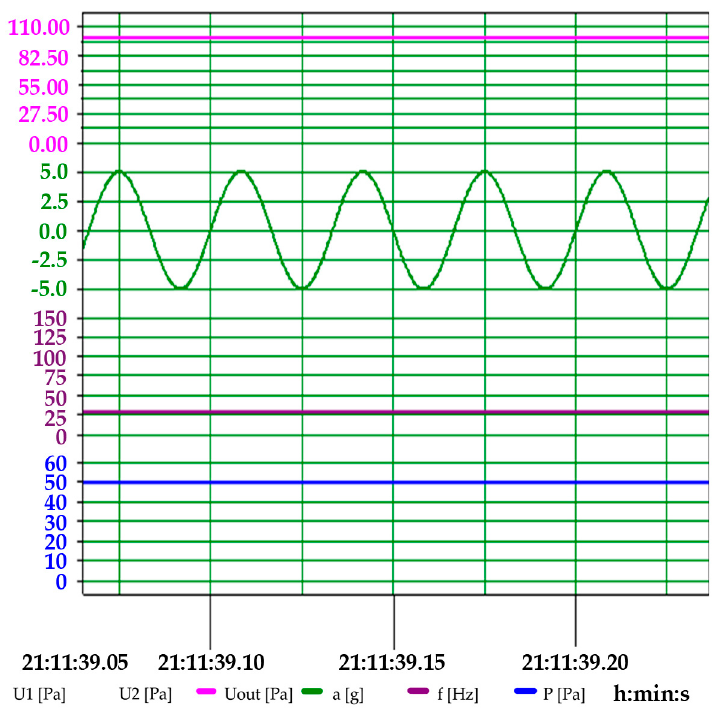
Figure 19. Waveforms of the experimental values of acceleration (a), pressure (p), and output signal (U out ) for dynamic acceleration with vibrations and with an amplitude of 5 g, frequency of f = 30 Hz, and pressure excitation of p = 50 Pa for the double-membrane transducer